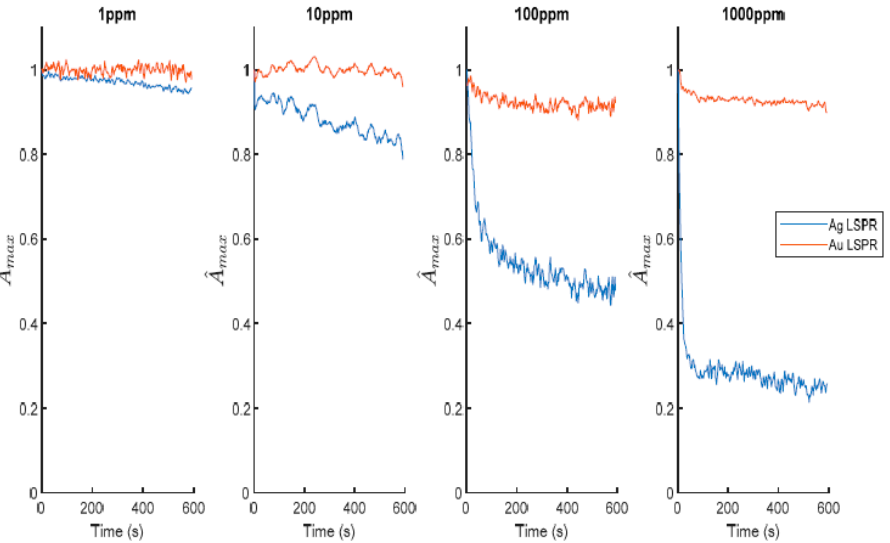
Figure 16. Evolution of the normalized LSPR spectra for different concentrations of the analyte (H 2 O 2 ) from 1 up to 100 ppm. Reprinted with permission of [50].